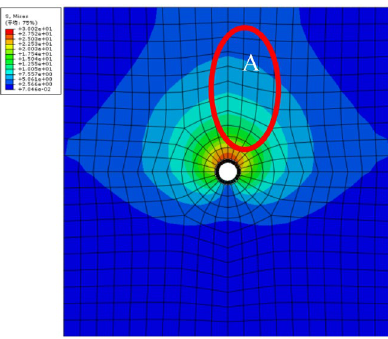
Figure 6. Tensile stress from numerical simulation under non-uniform